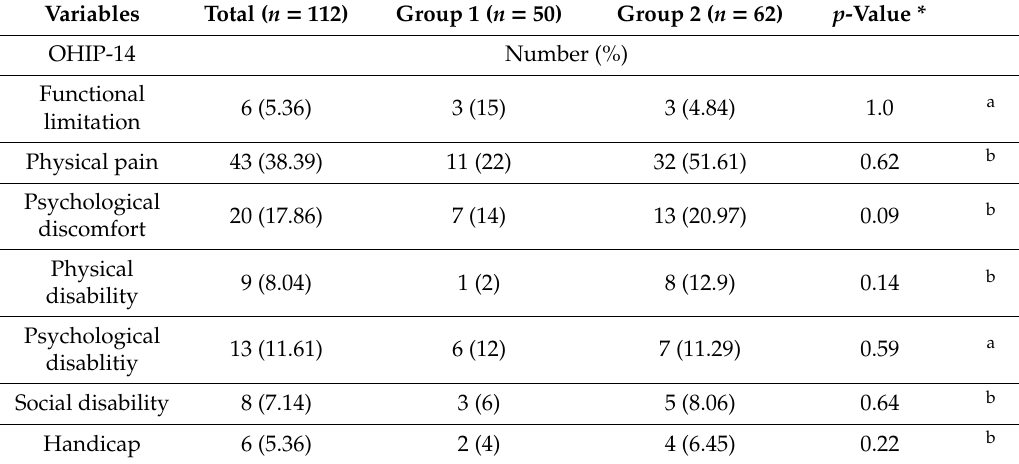
Table 4. Number of subjects reporting negative social impact by